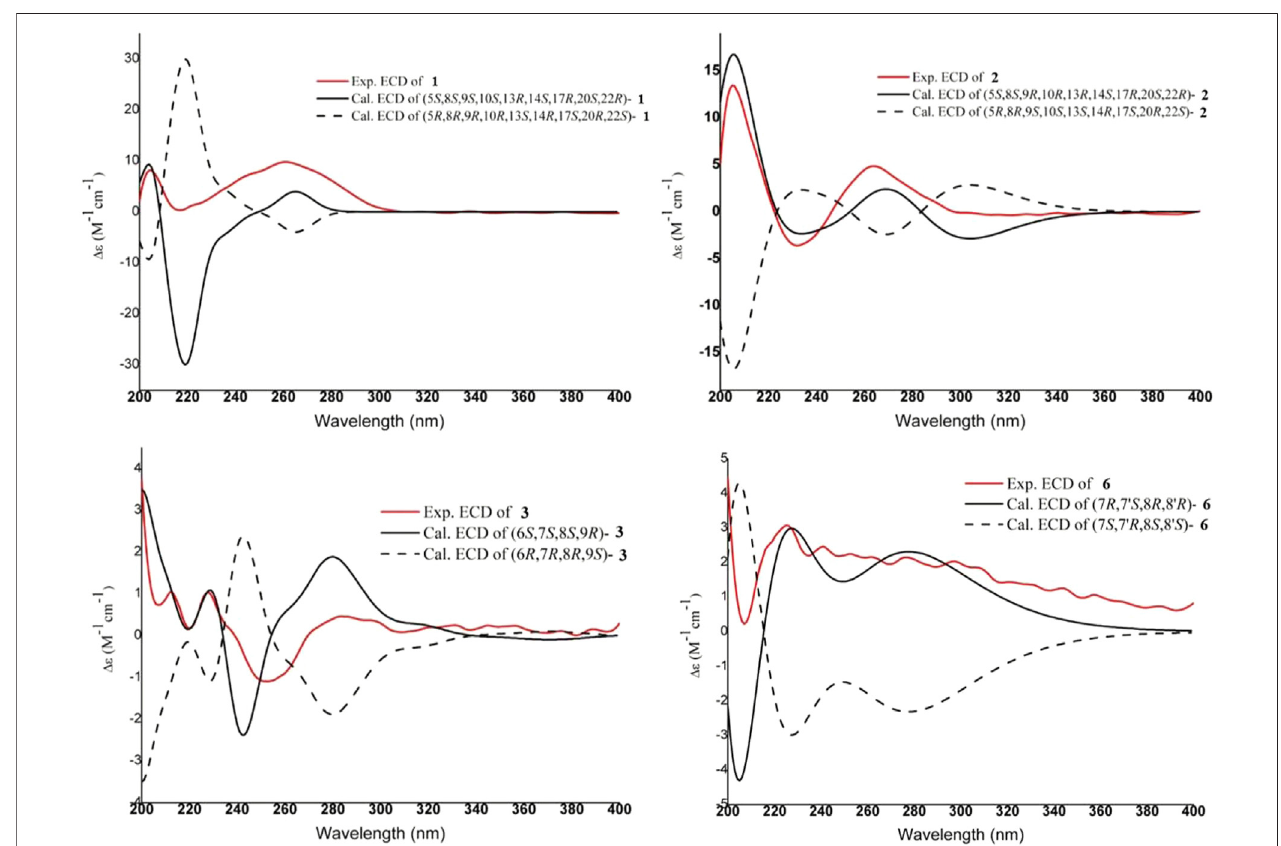
FIGURE 3 | Experimental and calculated ECD spectra of compounds 1 – 3 and 6